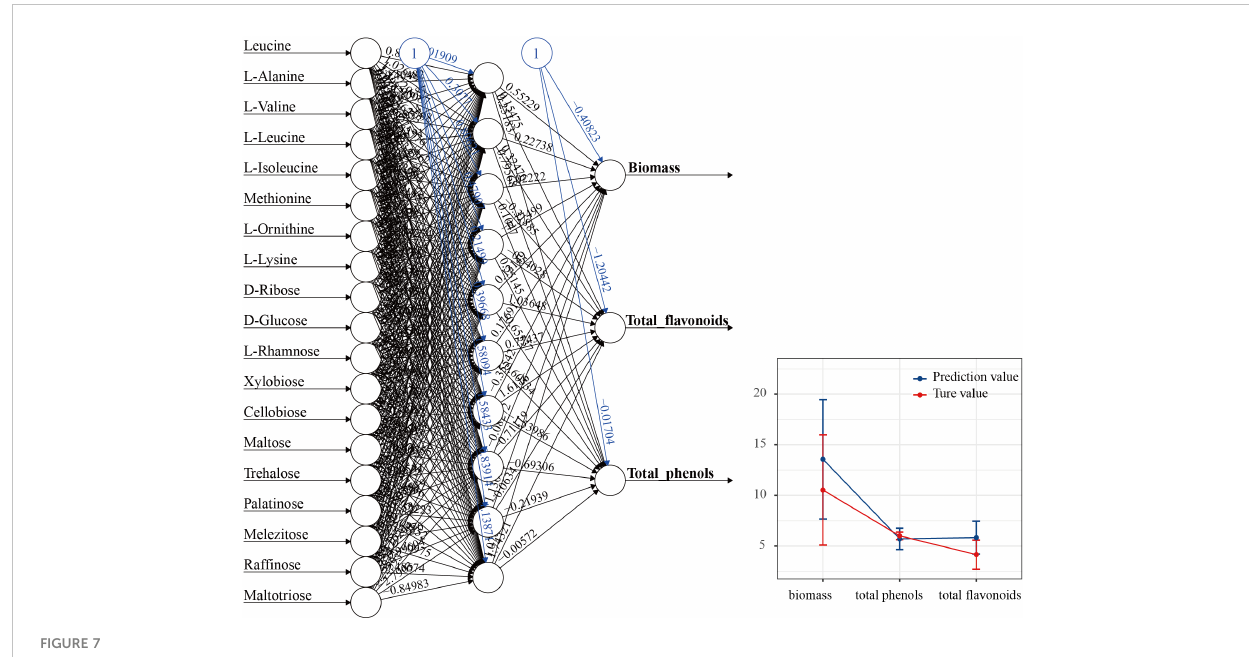
FIGURE 7 Arti fi cial neural network